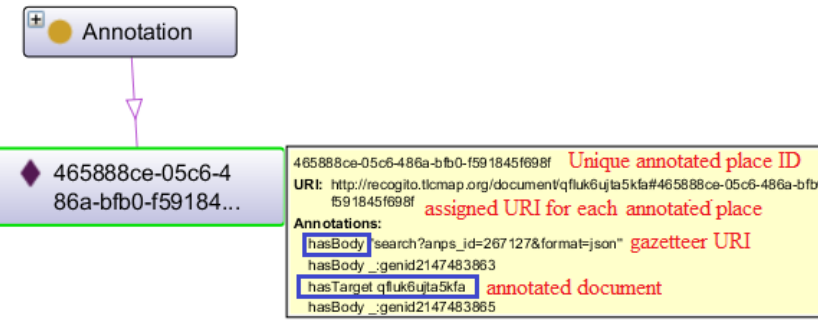
Figure 7. Annotation “ Guildford ” in the form of RDF downloaded from Recogito/TMT.